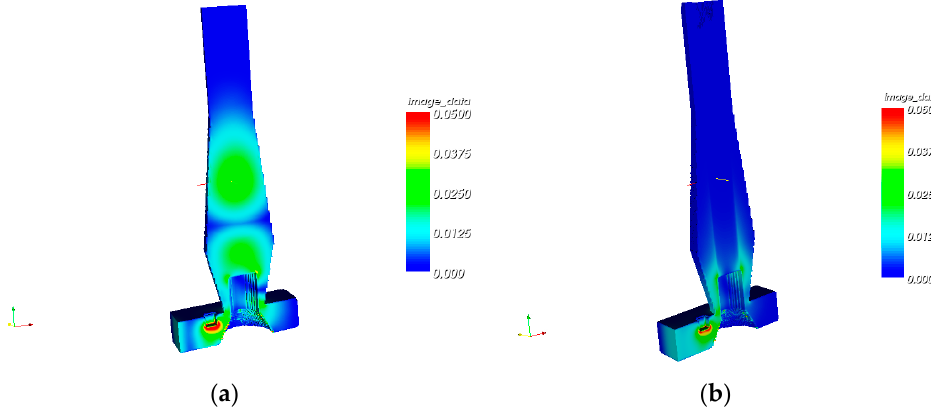
Figure 6. Simulated electric field strength in the cross section of the plasma torch, normalized so that the 0.0125 scale corresponds to an electric field of 60 V/m in the cases of: ( a ) pre-plasma ignition condition (empty applicator); ( b ) after plasma ignition (cylindrically loaded applicator).